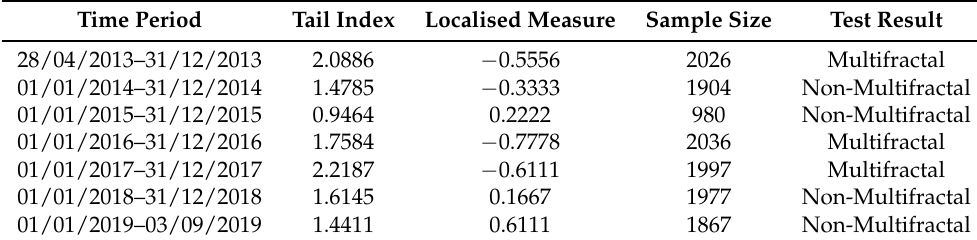
Table A2. Local hypothesis test results on daily Bitcoin open prices.